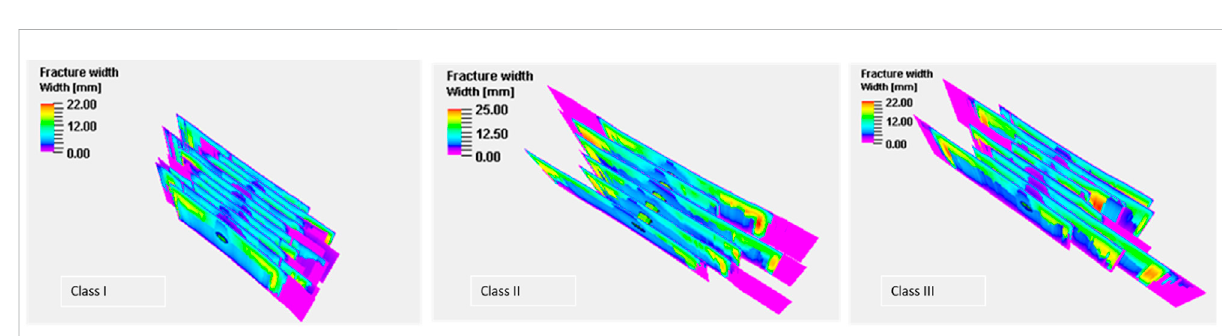
FIGURE 11 Simulated fracture length in various reservoirs of JQ511 platform at 14 m 3 /min displacement.